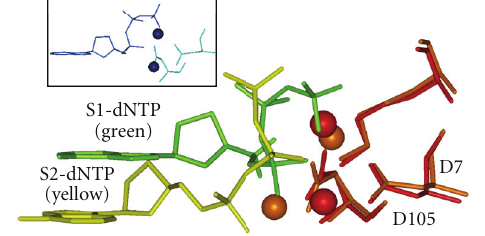
Figure 6: Side view of a dNTP in the “chair-like” shape S1-dNTP (green) versus the “goat-tail-like” shape S2-dNTP (yellow). Key amino acids (only D7, D105, and K159 are shown) from a Dpo4 structure adopting the S1-dNTP shape were superimposed on the same amino acids in a Dpo4 structure adopting the S2-dNTP. Spheres are divalent cations (S1-dNTP/red and S2-dNTP/brown). S1-dATP from T7 DNA polymerase is also shown (insert, blue). X- ray coordinates are from 1SOM-B for Dpo4/S1-dNTP, 1RYS-A for Dpo4/S2-dNTP, and 1T7P for T7